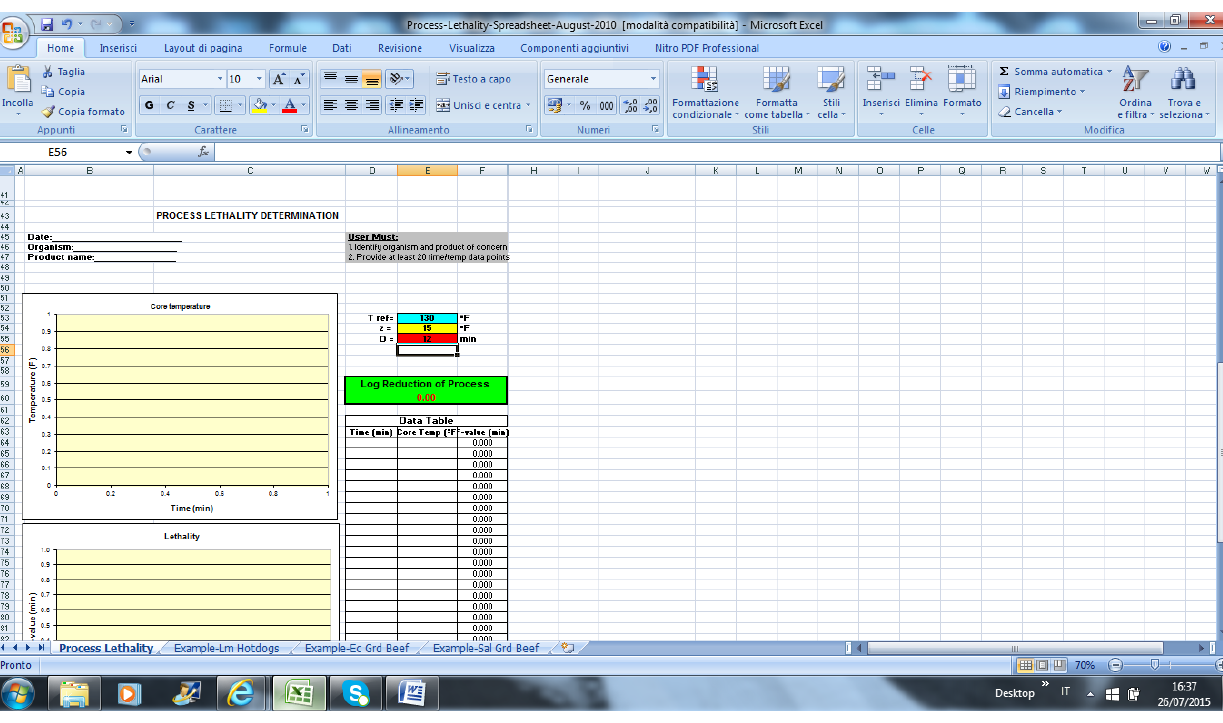
Figure 5. Screen of lethality spreadsheet (released August